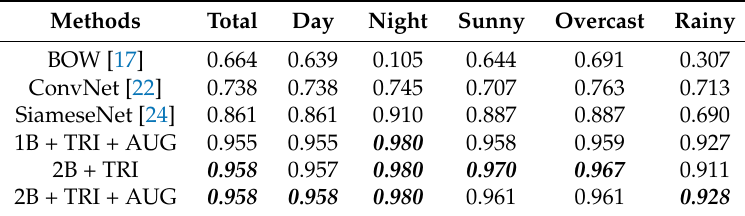
Table 5. Precision of compared methods in high traffic